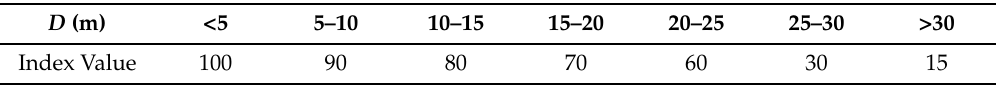
Table 10. Groundwater depth ( D ) scoring criterion.